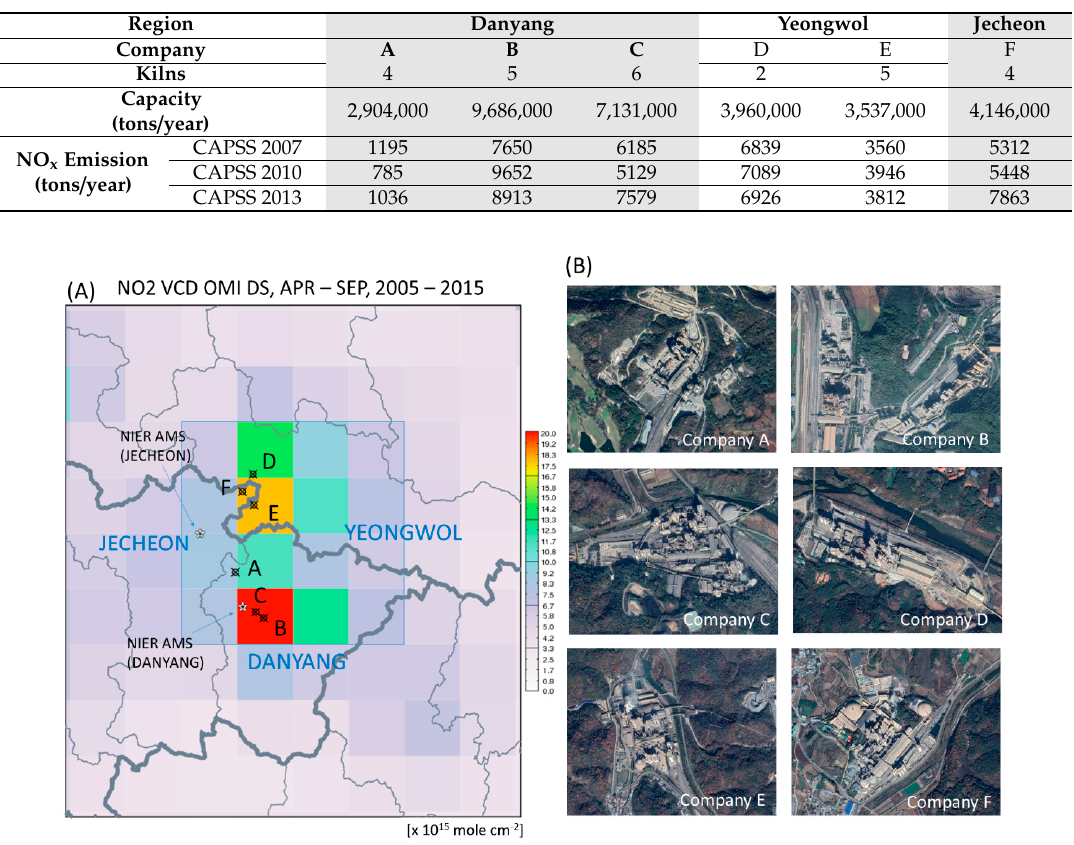
Table 1. Six cement factories in the YDJ region, listed with number of kilns, production capacity, and NOx emissions (CAPSS 2010) from each factory.